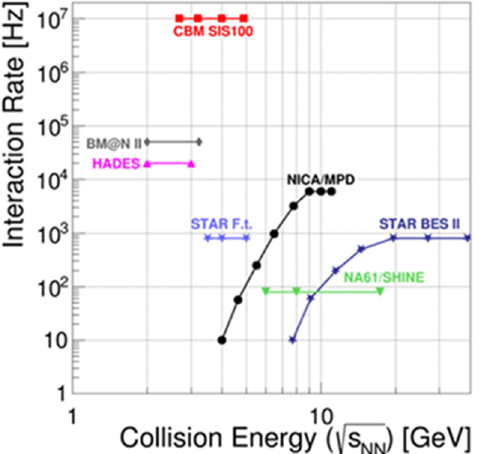
Figure 14. The Au + Au interaction rates as a function of collision energy for existing and emerging experiments (see text, taken from [47]). STAR F.t. stands for STAR fixed target mode.